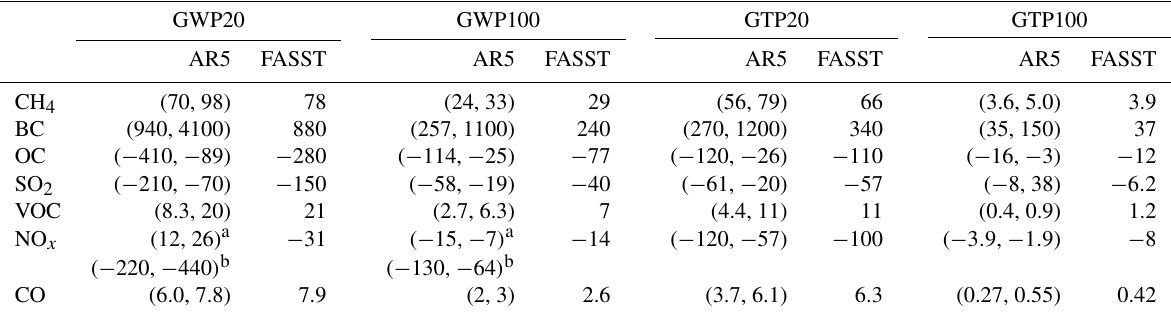
Table 13. Global GWP and GTP values’ 95% CI range (excluding indirect radiative effects) from IPCC AR5 (Forster et al., 2007) and from FASST based on RCP year 2000 emissions and the regional forcing efficiencies listed in Table S6.2 (all numbers rounded to two significant